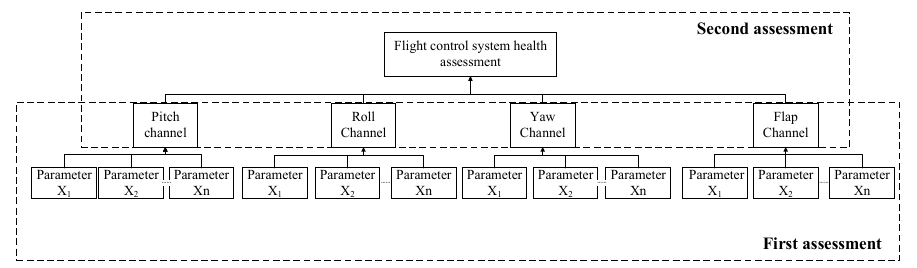
Figure 1. Health assessment model of flight control system.